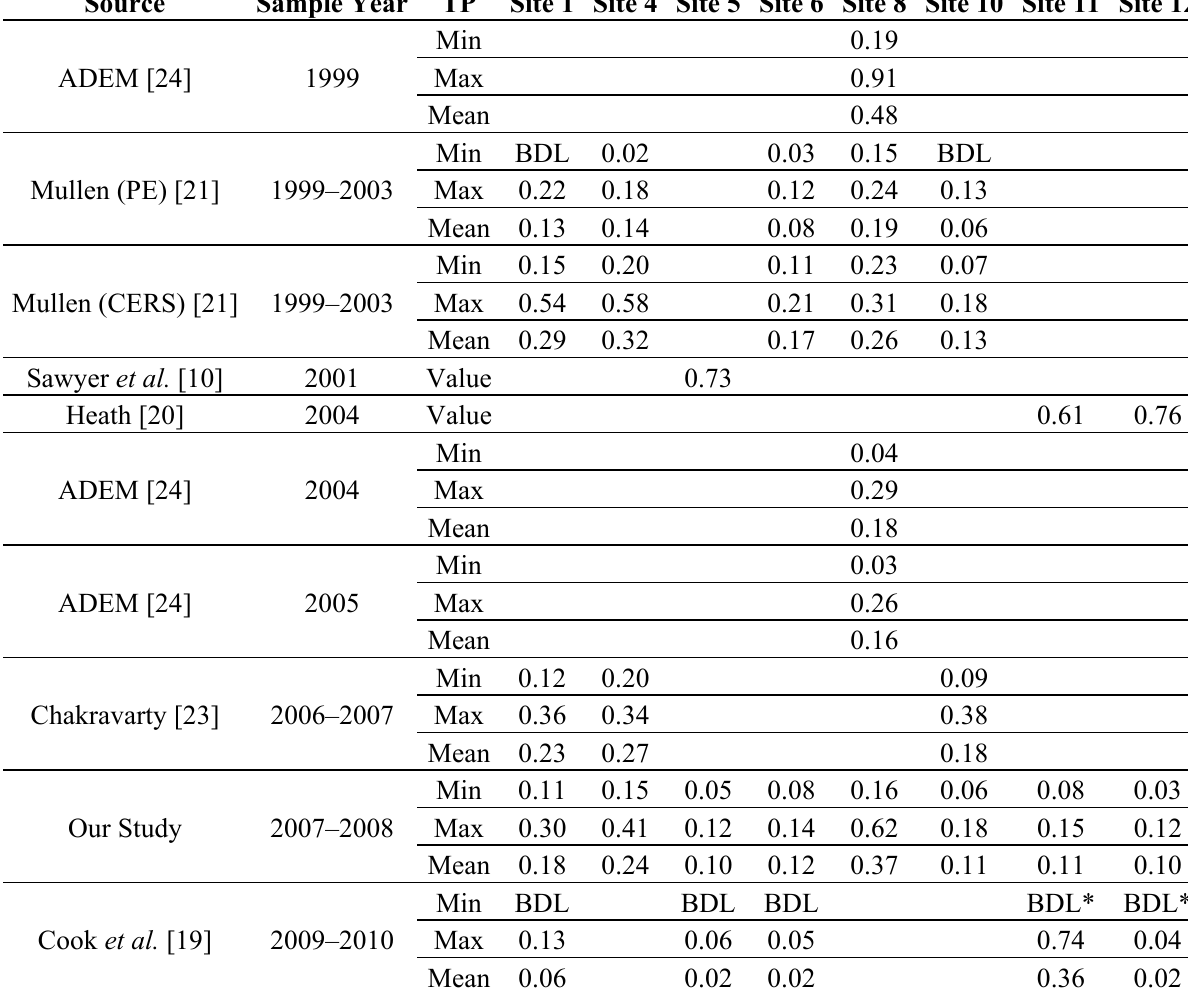
Table 2. Minimum, maximum, and mean (if available) of total phosphorus (TP) concentrations from historical sources in chronological sampling order, with coinciding sites, along with our data.